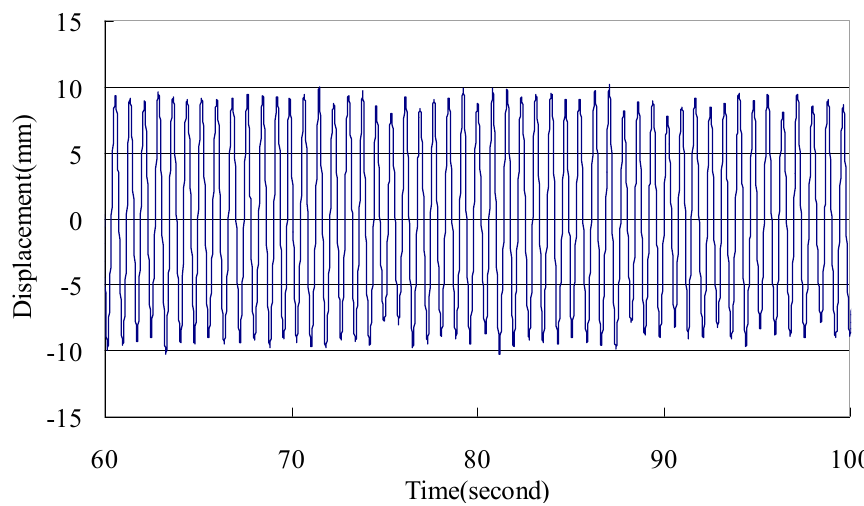
Figure 3. Displacement curve of the top deck when the pipeline fracture occurred.